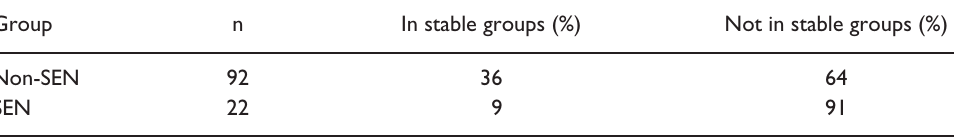
Figure 2. Example of NEGOPY groups with modification at T1 and T2. Table 4. Proportion of students in stable